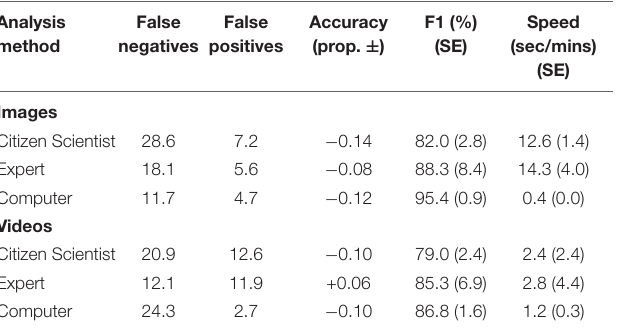
TABLE 1 | Summary of performance measures comparing averaged scores from computer versus humans (citizen scientists and experts). Analysis method